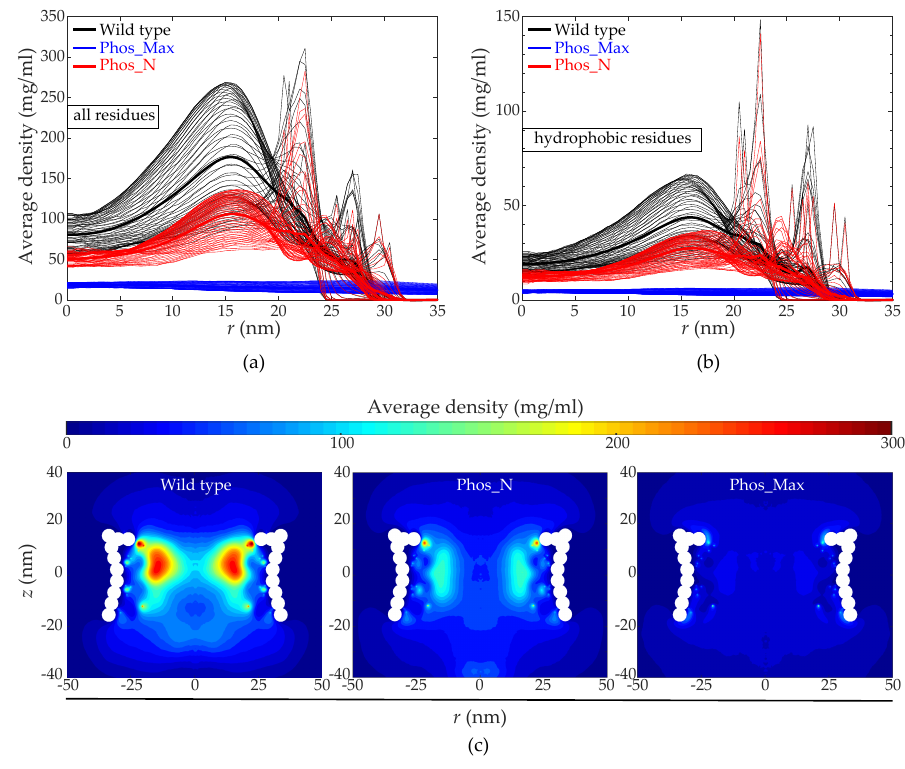
Figure 4. Disordered protein structure inside the wild-type and phosphorylated NPCs. ( a , b ) Time-averaged radial density distribution inside wild type (black), Phos_N (red) and Phos_Max (blue) NPCs for ( a ) all residues, and ( b ) hydrophobic residues. The thin lines represent the density at different positions along the z -axis separated by 1 nm, in the range of | z | < 15.5 nm (height of the NPC), with the mean density plotted as thick lines. ( c ) The rz -density map for the wild type (left panel), Phos_N (middle panel), and Phos_Max (right panel) NPCs. The wild type shows the characteristic highly dense doughnut-like structure [35]. The Phos_N NPC shows a density-depleted doughnut-like structure, whereas the Phos_Max NPC shows a significantly less dense and rather uniform density